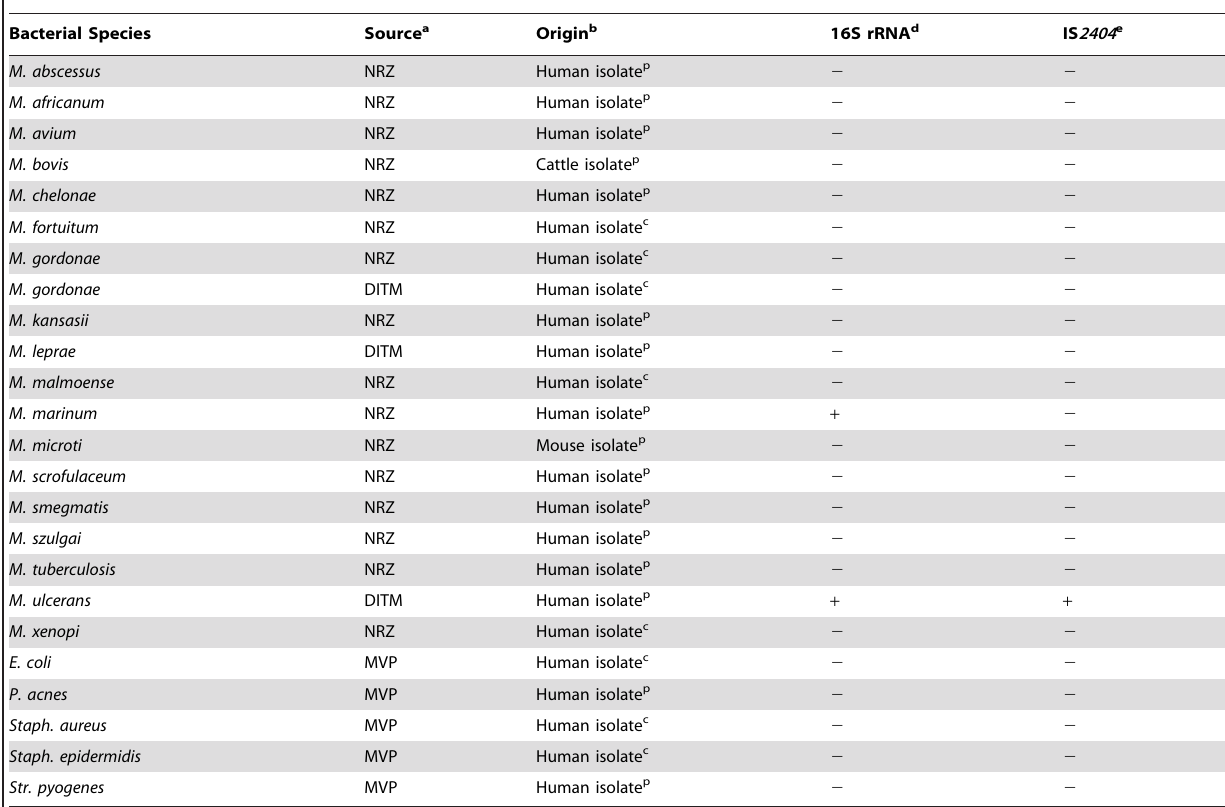
Table 2. Specificity of 16S rRNA and IS 2404 qPCR assays.